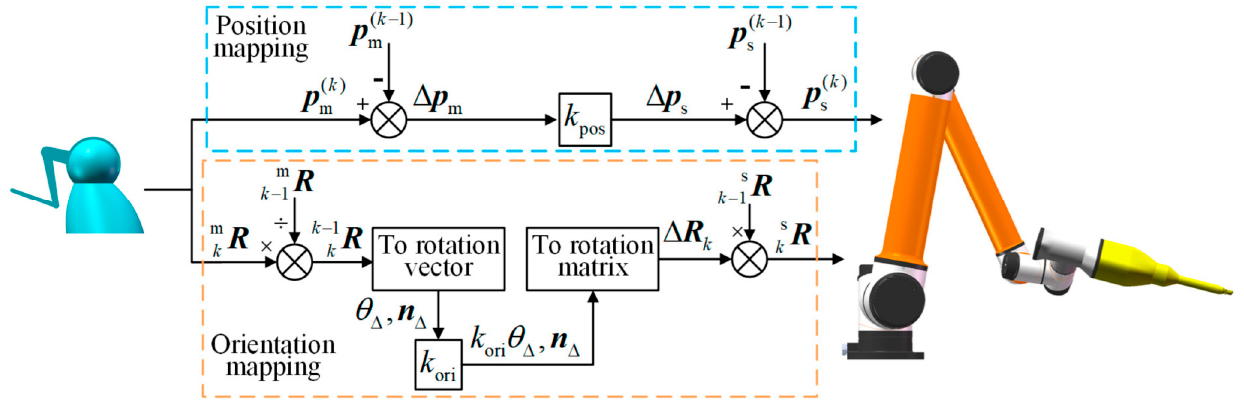
Figure 2. Master–slave mapping of the OSRS.